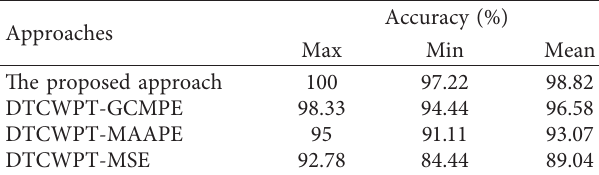
Figure 14: The classification results of five approaches during 25 trials. Table 2: The classification results of different